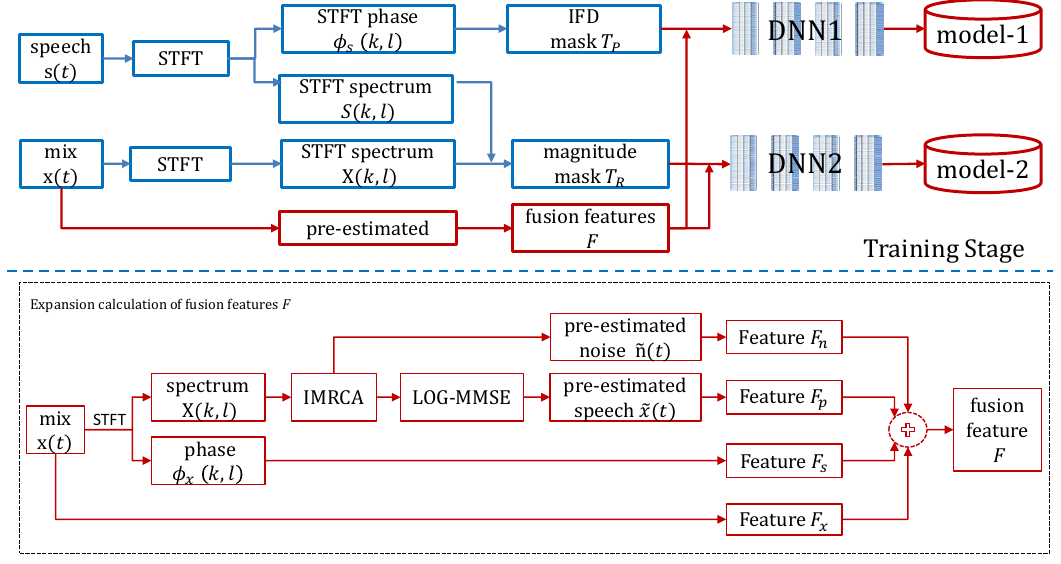
Figure 2. Training scheme of the proposed